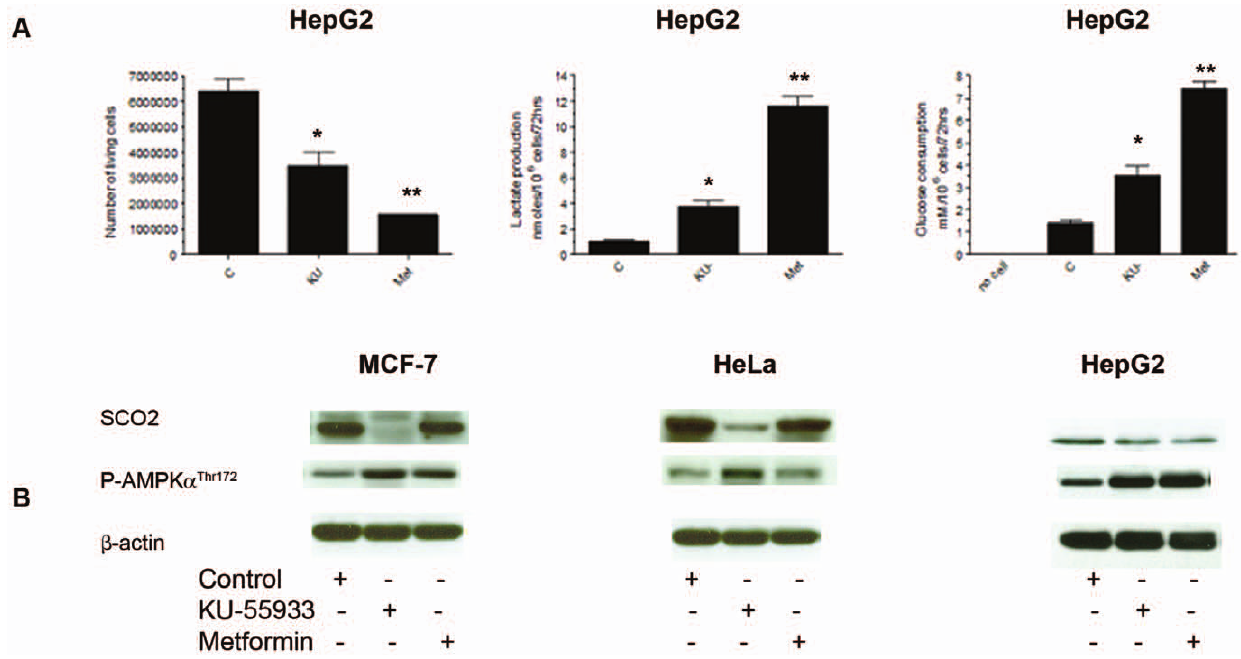
Figure 4. Effects of KU-55933 and metformin on cell number, lactate production, glucose consumption and SCO2 levels in different cancer cell lines. Cells were exposed to KU (10 m M) or metformin (5 mM) for 72 hrs. ( A ) The effect of KU-55933 or metformin on cell number was measured by counting cells able to exclude Trypan blue. Cell number was significantly reduced by KU-55933 (* P =0.0394) and by metformin (** P =0.0058). KU-55933 and metformin stimulated lactate production. Lactate production was significantly increased in cells treated with KU-55933 (* P =0.0012) or metformin (** P =0.0222). Glucose consumption was increased with exposure to either KU-55933 (* P =0.0034) or metformin (** P =0.0385) treated cells. ( B ) MCF-7, HeLa and HepG2 cells were exposed to KU-55933 (10 m M) or metformin (5 mM) for the indicated time. After harvesting, cells were lysed and prepared for immunoblot analyses using antibodies against SCO2, phospho-AMPK (Thr 172 ). ß-actin is shown as a loading control. The results are representative of three individual